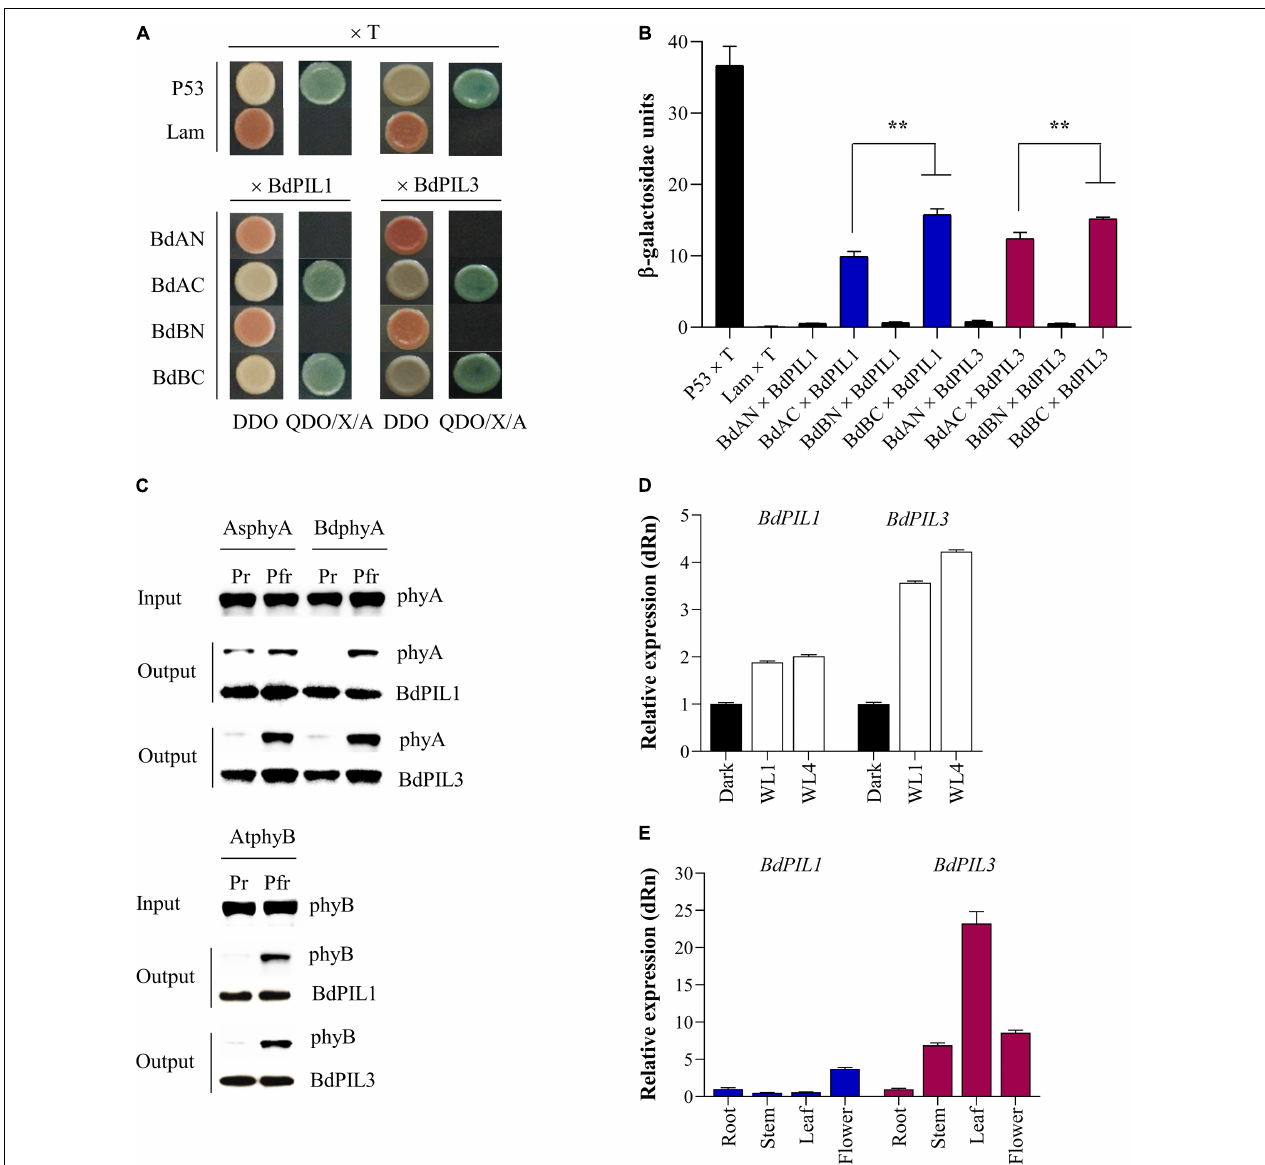
FIGURE 1 | Isolation and expression analysis of two Brachypodium distachyon phytochrome-interacting factor-like (BdPIL) proteins. (A) Yeast two-hybrid analysis of BdPIL1 (Bradi1g13980) and BdPIL3 (Bradi2g11100) with Brachypodium phytochromes. BdAN and BdAC, N- and C-terminal domains of B. distachyon phytochrome A (BdphyA); BdBN and BdBC, N- and C- terminal domains of B. distachyon phytochrome B (BdphyB). Yeast cells were grown on non-selective (DDO) and selective (QDO/X/A) media. P53 × T and Lam × T were included as positive and negative controls, respectively. (B) β -galactosidase assay to quantify the interactions shown in A. Data represent the means ± SD from three independent replicates, and significant difference is indicated by ** ( P < 0.01, Tukey’s test). (C) In vitro protein–protein interaction analysis between BdPILs and phytochromes. Pr and Pfr forms of full-length Avena sativa phyA (AsphyA), BdphyA, or Arabidopsis thaliana phyB (AtphyB) was incubated with GST/strep-tagged BdPIL1 or BdPIL3. Glutathione bead-bound proteins (output) were analyzed by western blotting. (D) Expression analysis of BdPIL1 and BdPIL3 in the absence and presence of light. Five-day-old dark-grown seedlings of Brachypodium (inbred line Bd21-3) were either kept in the dark or transferred to white light (WL, 100 µ mol · m − 2 · s − 1 ) for 1 and 4 h before harvesting for qRT-PCR analysis. (E) Expression analysis of BdPIL1 and BdPIL3 in different tissues of Brachypodium plants. For the qRT-PCR analysis, BdUBC18 expression level was used for data